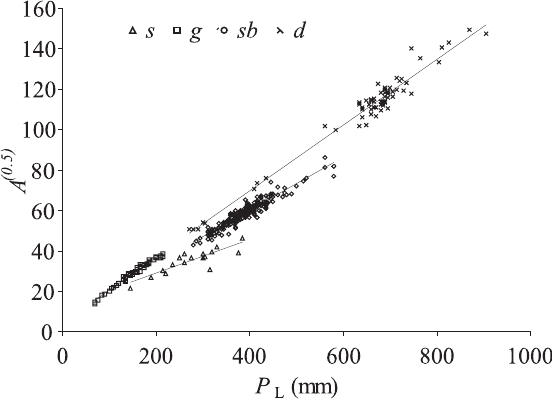
Fig . 4 – relationships between square root transformed caudal fin area ( A 0·5 ) and precaudal length ( P ) in Galeus melastomus ( g , open l squares), Scyliorhinus canicula ( s , open triangles), Squalus blainvil- lei ( sb , open circles) and Dalatias licha ( d , asterisks). Table 4 – results of the PermanoVa based on caudal fin aspect ratio, body size-standardised caudal fin area and span, hepatosomat-